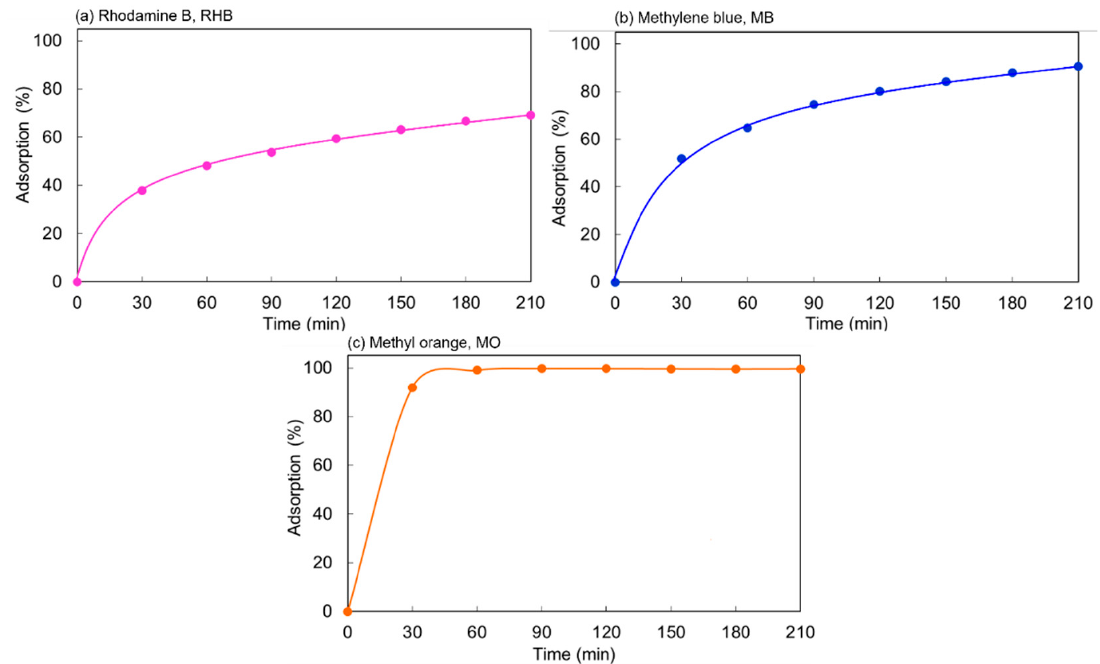
Figure 8. Adsorption capability of P-LS towards ( a ) RHB, ( b ) MB and MO ( c